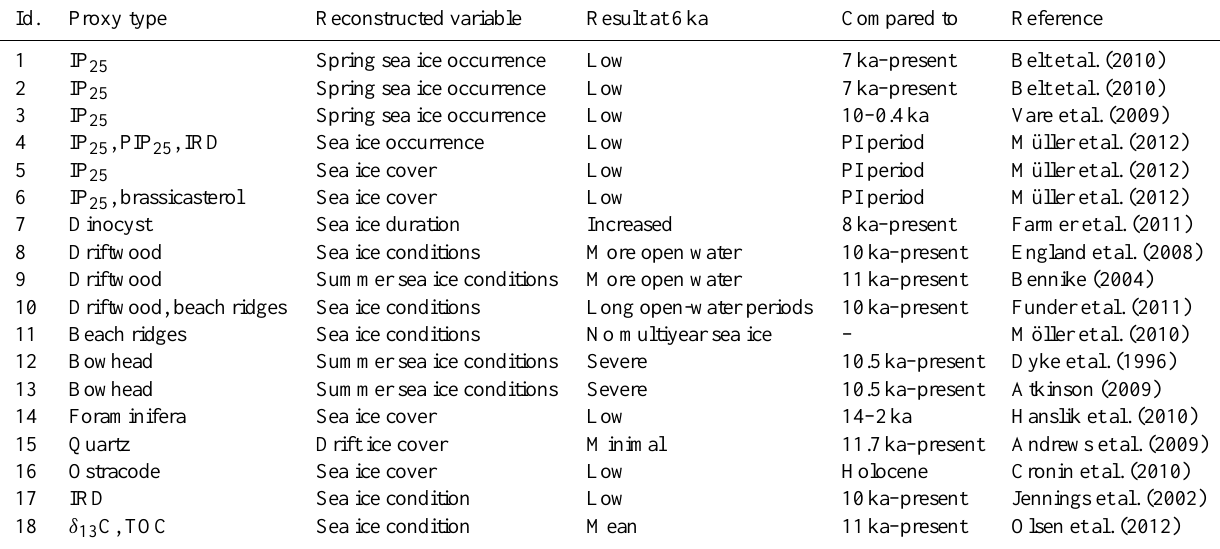
Table 3. Arctic sea ice reconstructions displayed in Fig. 1 and their signal in the MH as compared to the reconstruction means.